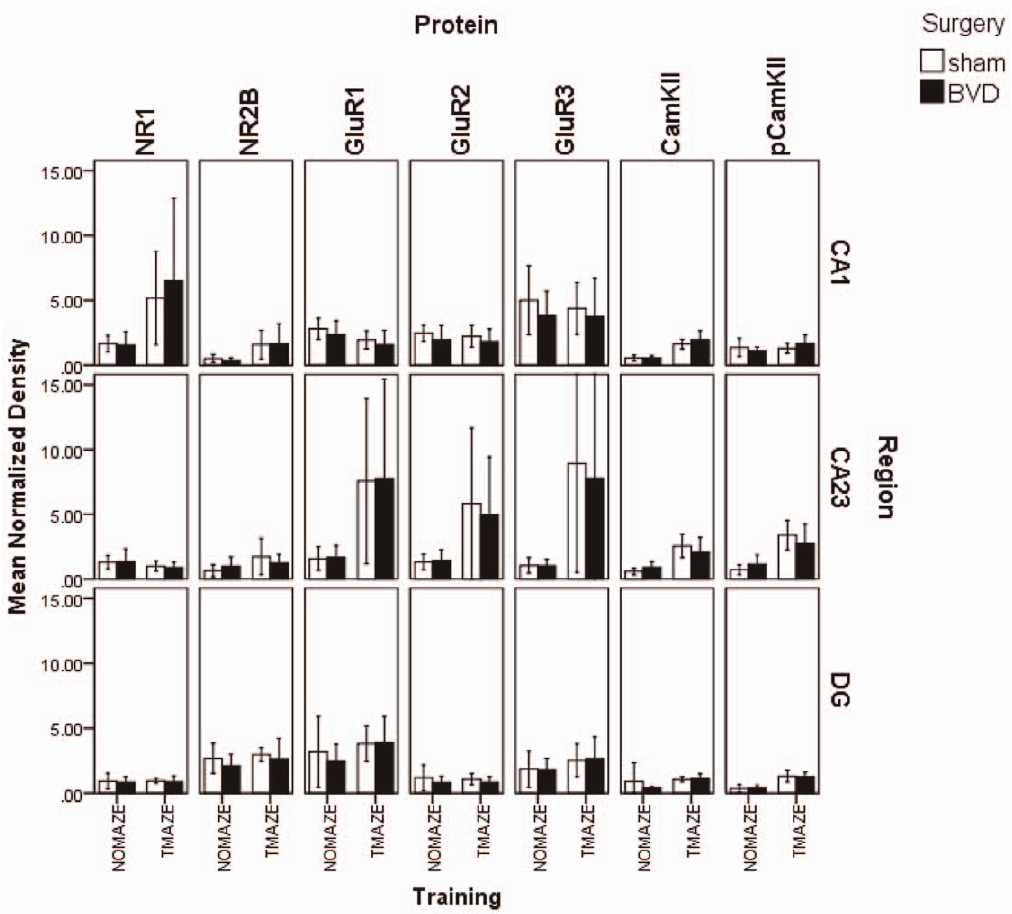
Figure 2. Mean normalized density of expression of NR1, NR2B, GluR1, GluR2, GluR3, CaMKII a and pCaMKII a in the CA1, CA2/3 and DG regions of the hippocampus at 6 months following BVD or sham surgery for animals trained in a T maze or not trained in a T maze. Error bars represent 95% confidence intervals for the mean.